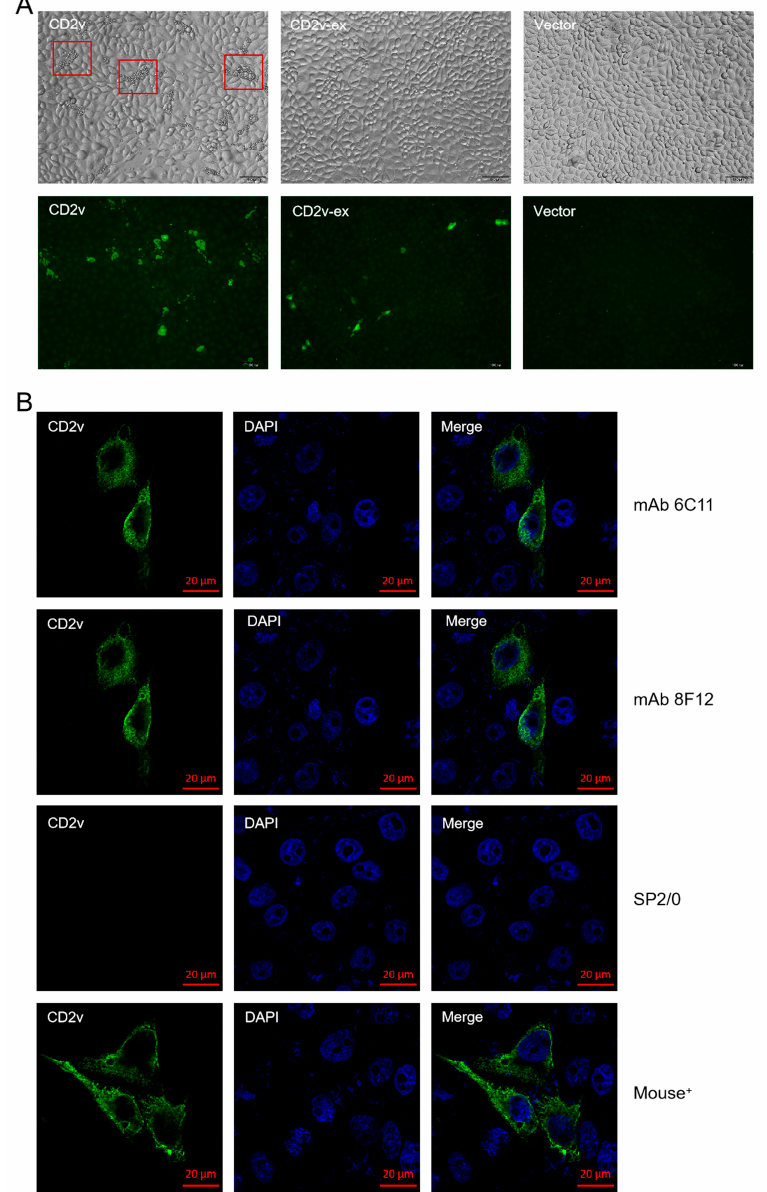
Figure 2. Localization of CD2v protein in transfected cells. ( A ) HAD test results of CD2v protein in transfected PK-15 cells. ( B ) IFA test results of mAbs 6C11 and 8F12 against CD2v. SP2/0 cell supernatants and anti-CD2v-ex mouse polyclonal antibodies (Mouse + ) were used as negative and positive controls,